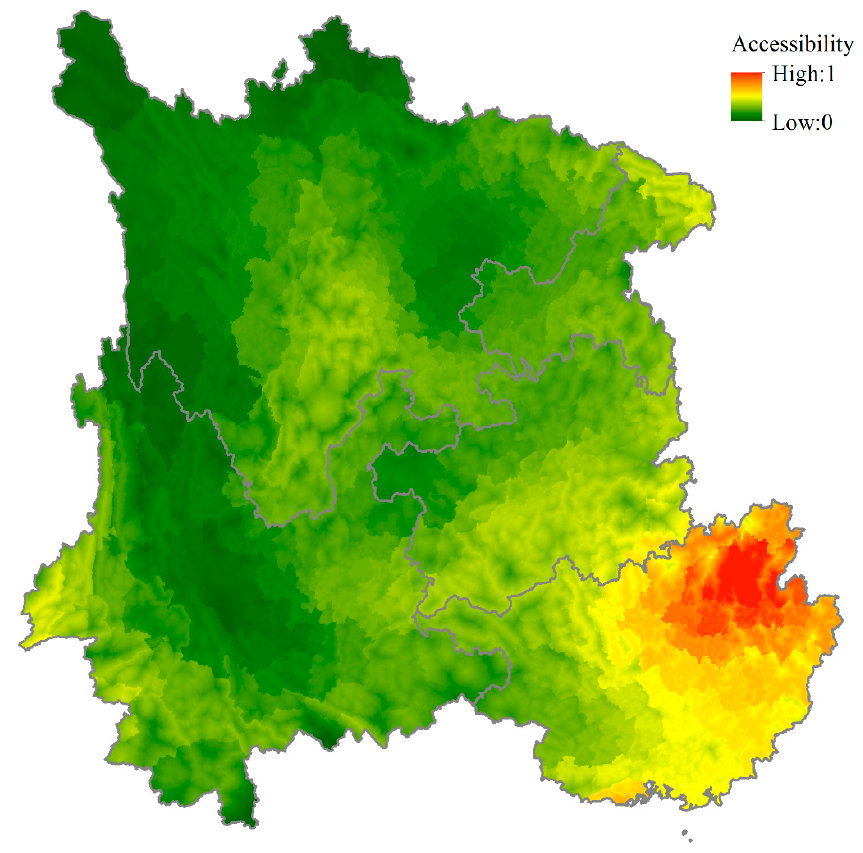
Figure 3. The spatial pattern of the water resource accessibility in Southwest China at the grid-scale.